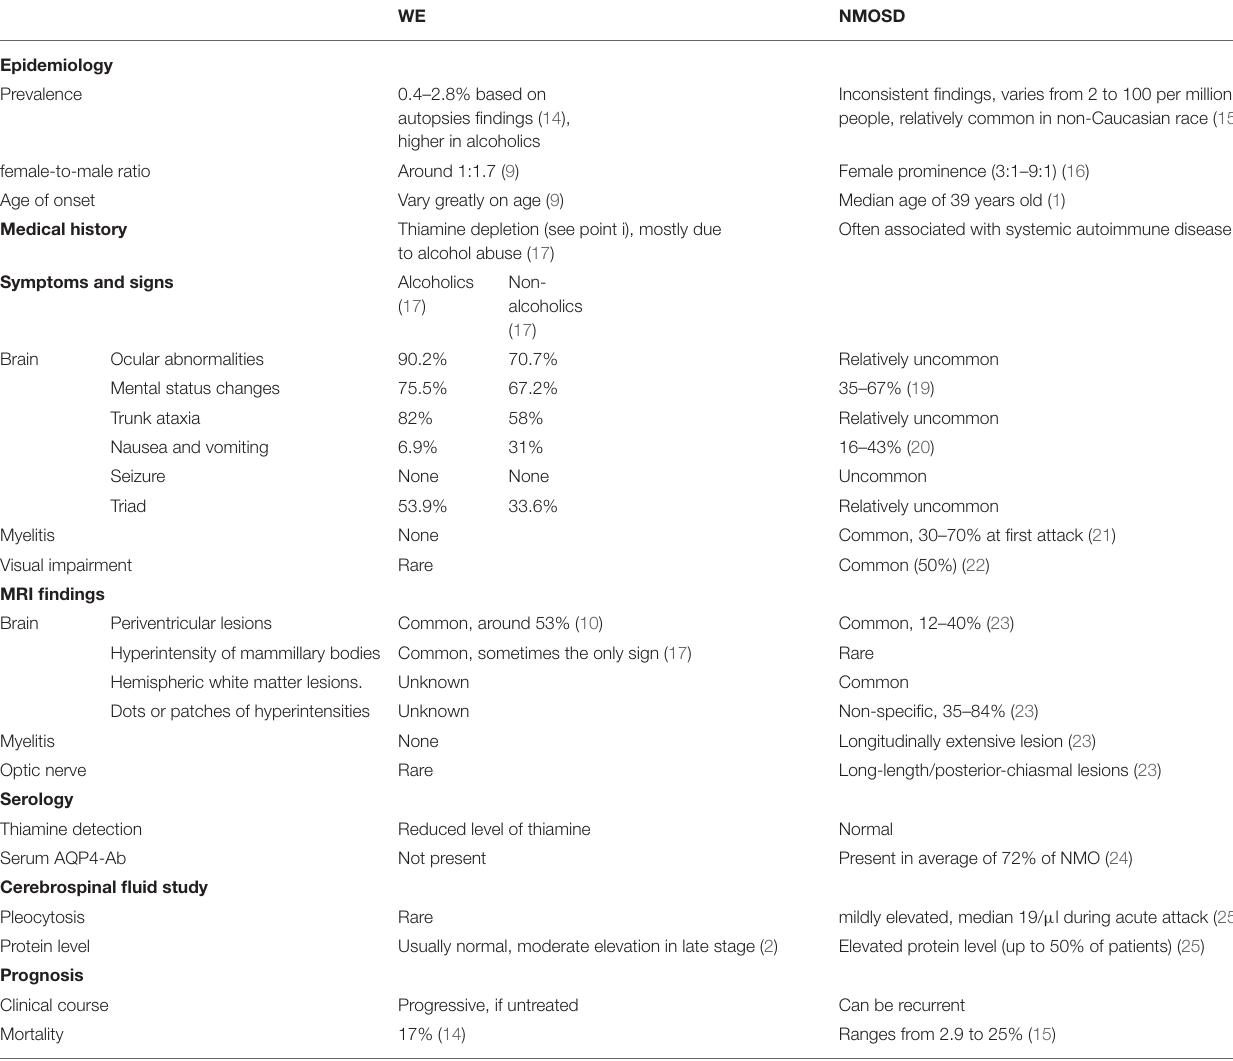
TABLE 1 | Distinctive characteristics of NMOSD from those of